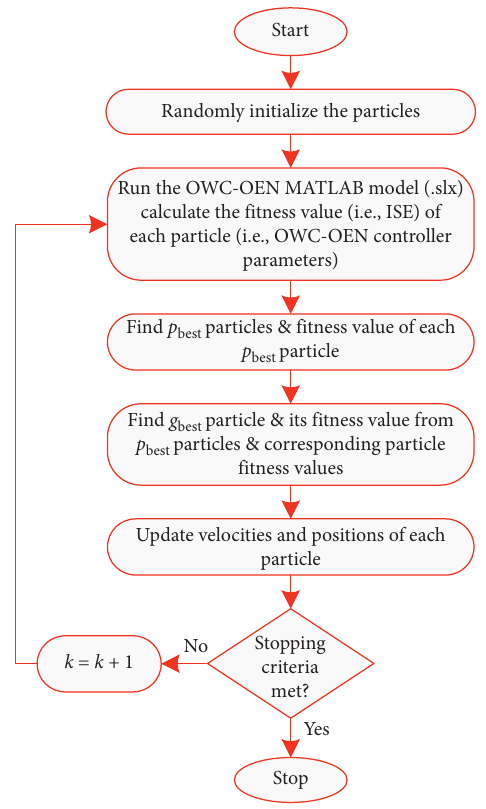
Figure 8: PSO algorithm flowchart for tuning OWC-OEN con- troller